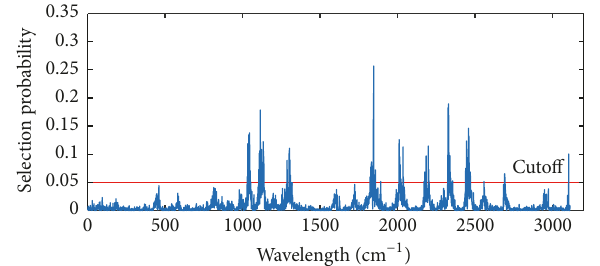
Figure 10: Selection probability of each wavelength for prediction of SSC.